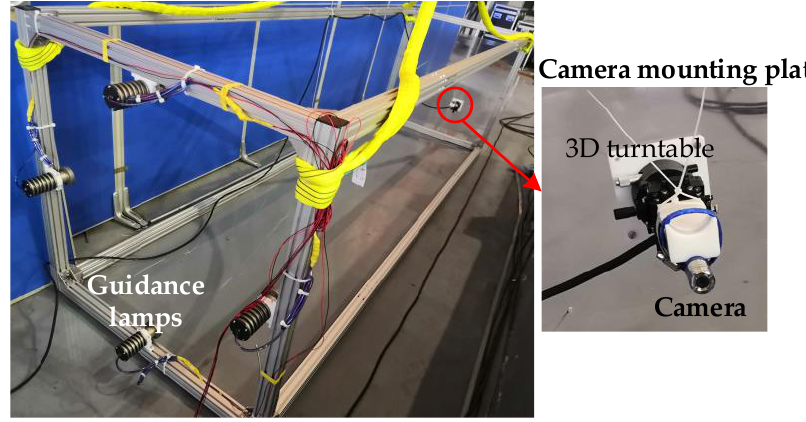
Figure 15. PPARD estimation test platform used in the study.